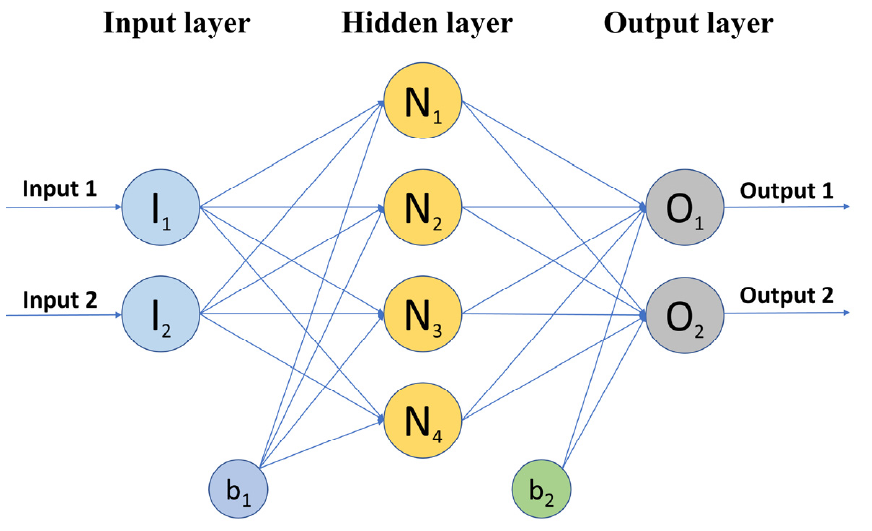
Figure 3. Schematic of three-layer MLP.